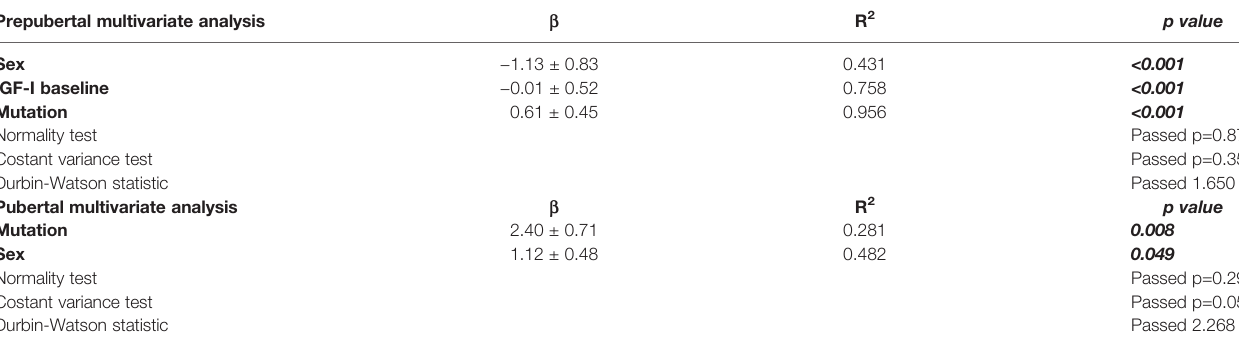
TABLE 4 | Multiple regression data for prepubertal and pubertal